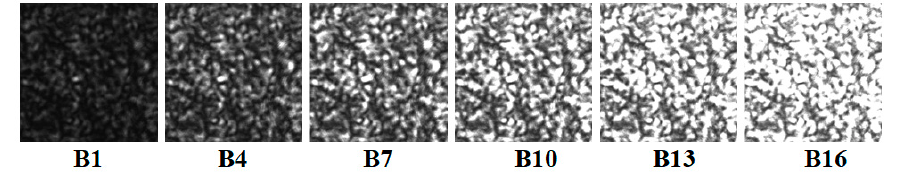
Figure 8. Speckle patterns collected at different camera exposure times.